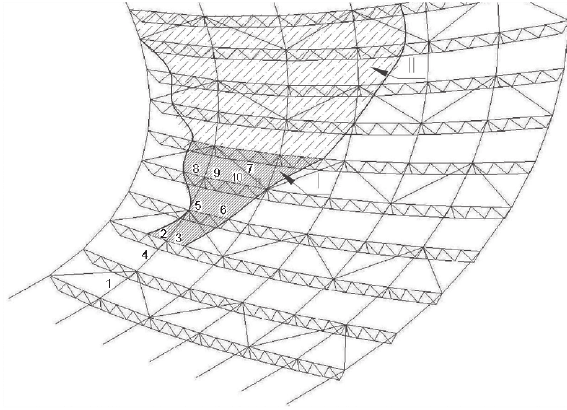
Fig. 4. Destructed shell area. Failure of members 1–11; I – destructed section; II – predicted section of further